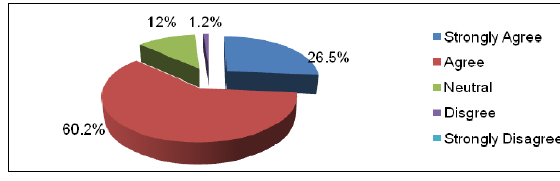
FIGURE 7 age group